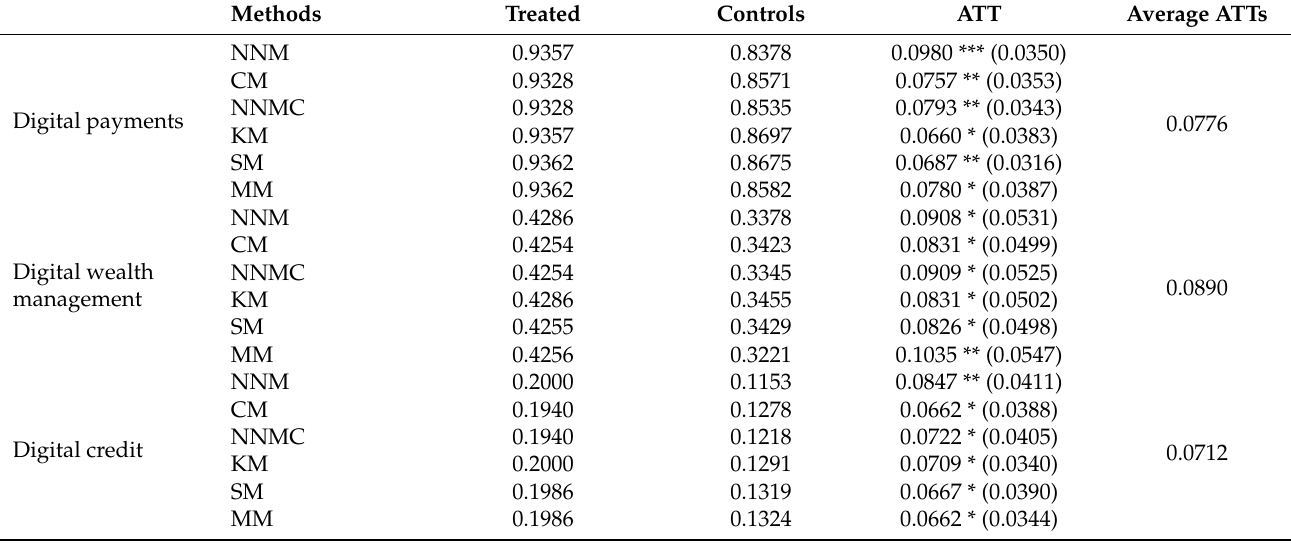
Table A3. The superposition effect of both online purchases and